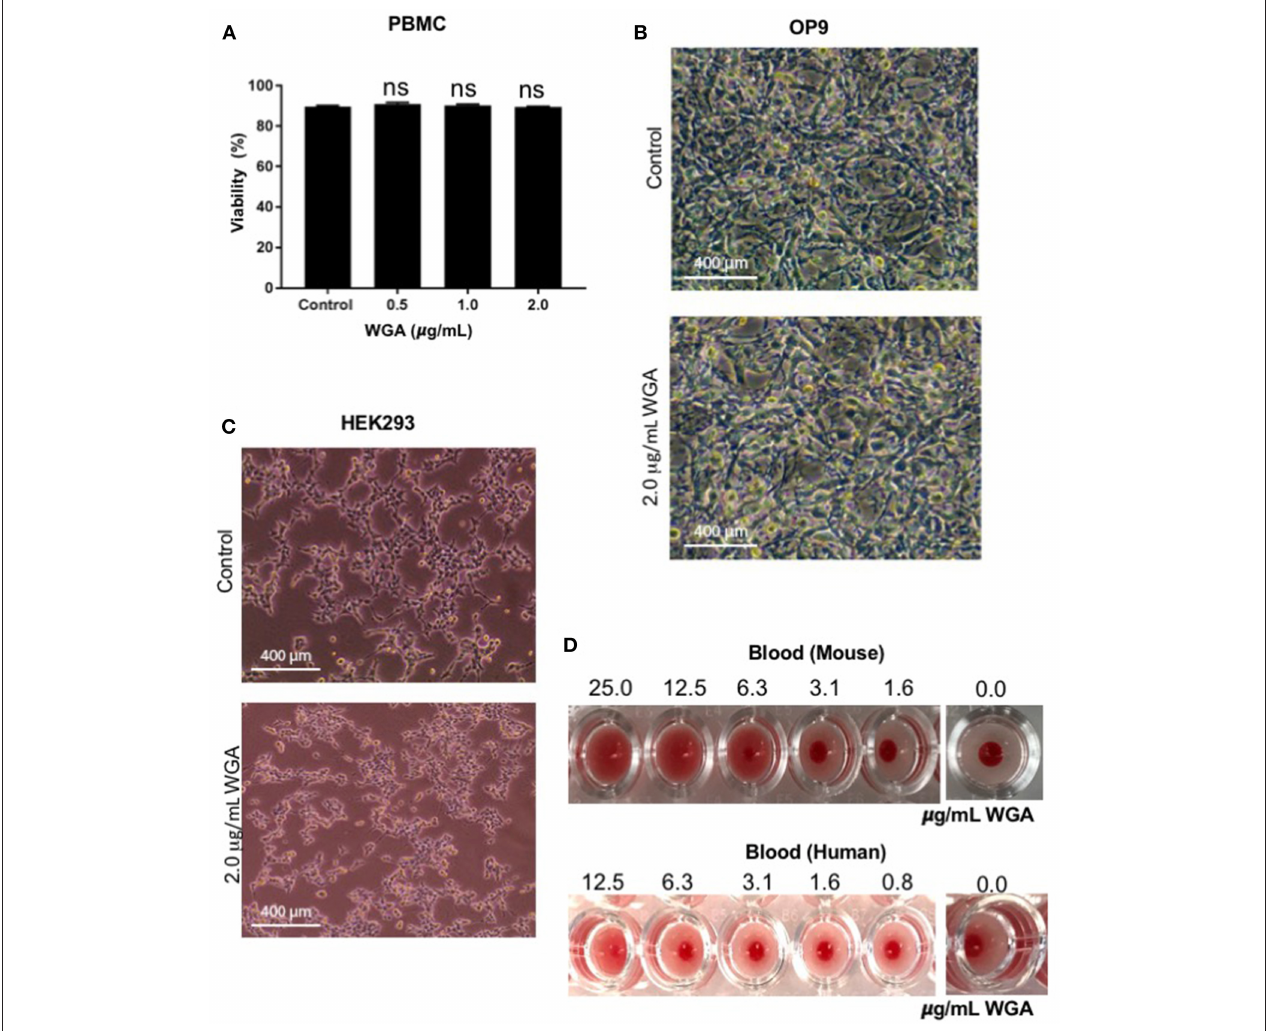
FIGURE 5 | WGA treatment exhibits little or no toxicity toward normal cells in vitro . (A) Viable peripheral blood mononuclear cells (PBMCs) treated with 0.5, 1.0, and 2.0 µ g/mL WGA for 24h were calculated by PI uptake using flow cytometry. (B) Light microscopy of OP9 stromal cells showing phenotype. Cells were treated with 2.0 µ g/mL WGA for 24h and imaged. Scale bar 400mm shown. (C) Light microscopy of HEK293 cells showing phenotype. Cells were treated with 2.0 µ g/mL WGA for 24h and imaged. Scale bar 400mm shown. (D) Hemagglutination assay on 96-well micro-plate of mouse and human blood using serial dilution of WGA (25 to 1.6 µ g and 12.5 to 0.8 µ g, respectively). Absence of lectin control (0.0 µ g) for mouse and human blood are included. ns > 0.05.